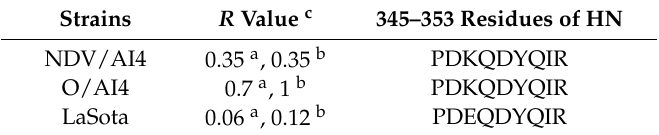
Table 1. Coefficients of antigenic similarity ( R ) between the three vaccines and JS-14-12-Ch. Strains R Value